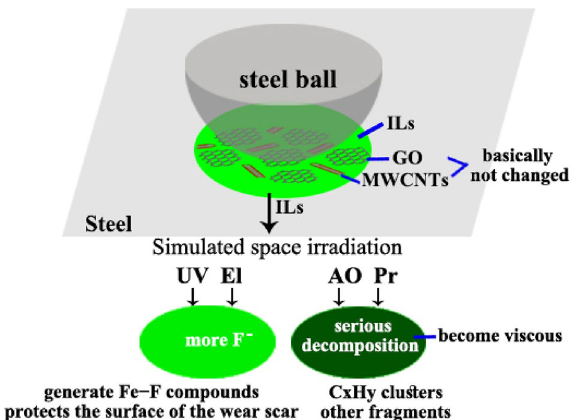
Figure 10. Schematic explaining the possible friction and wear mechanism for the composite coatings after the simulated space